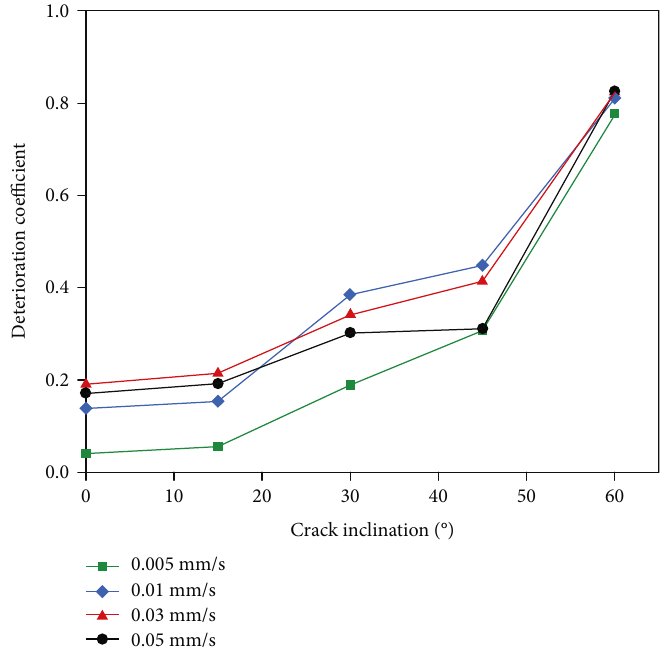
Figure 7: Relation curve between deterioration coe ffi cient of crack-grouting sandstone and crack